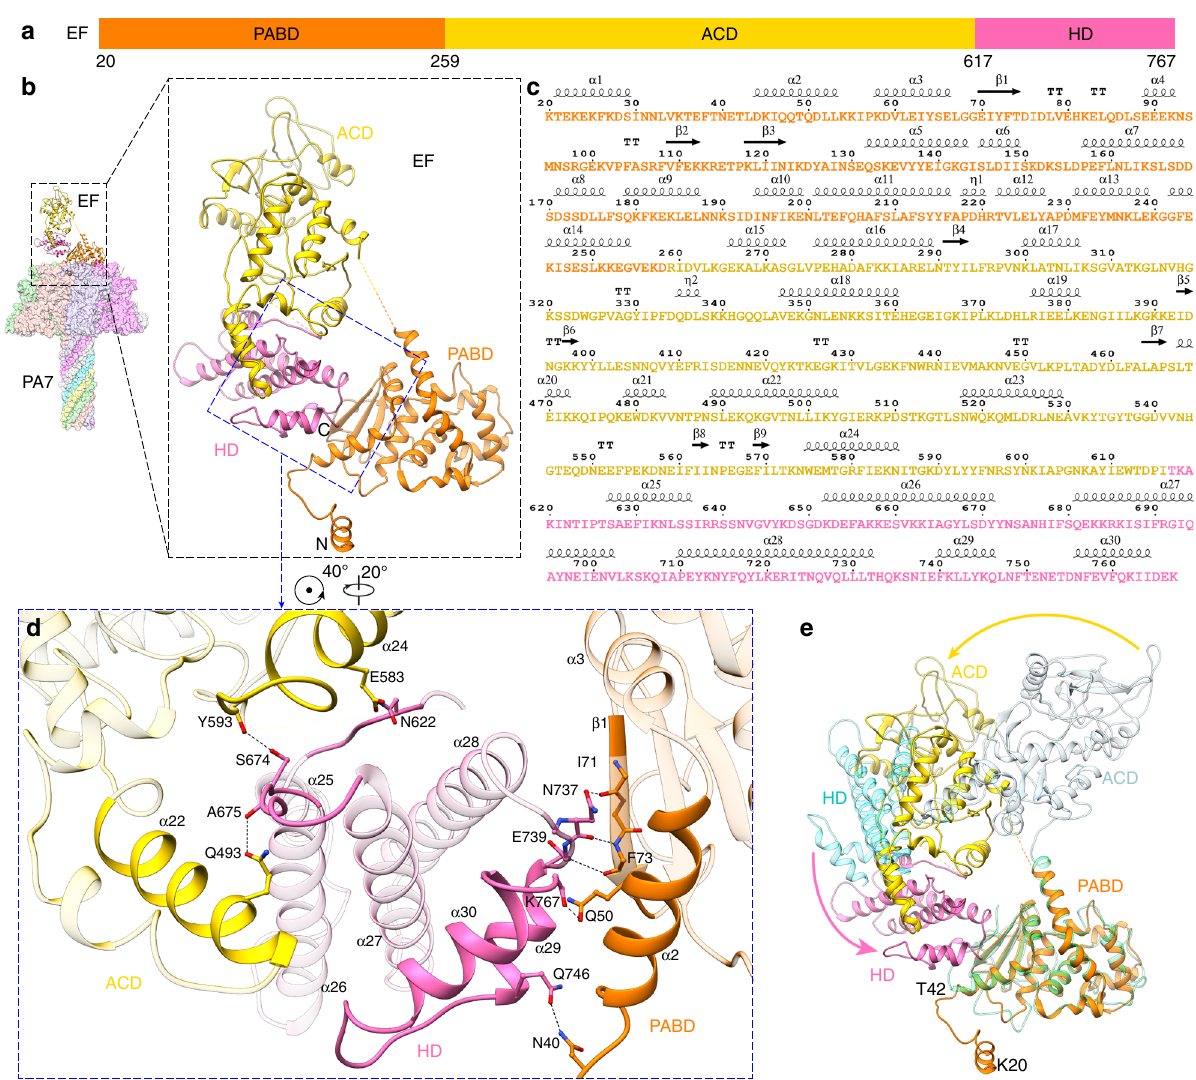
Fig. 3 Structural comparison of EF between its PA 7 -bound and CaM-bound forms. a Domain architecture of EF with individual domains colored and the boundary residues numbered. b Structure of PA 7 -EF with EF shown as ribbon and PA 7 as surface colored by protomers. The three domains of EF — PABD, ACD, HD — are colored as in a . c Sequence and secondary structures of the PA 7 -bound EF. d Close-up view at the interactions among PABD, ACD and HD domains in PA 7 -bound EF. The structural elements involved in domain interactions are highlighted and hydrogen bonds are shown as dashed lines. e Superposition of EF structures in its PA 7 -bound and CaM-bound (PDB: 1XFY) forms. The two EFs are aligned by the PABD domain for clarity. Three domains of CaM-bound EF — PABD, ACD, HD — are colored in green, light blue and cyan, respectively. Domain reorganizations are marked by